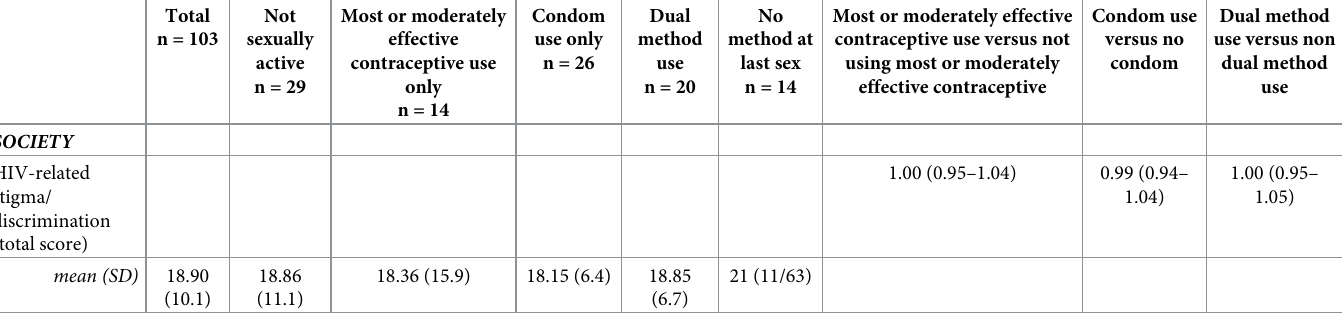
Table 4. Description of society-level factors among young HIV-infected study participants and association between these factors and most or moderately effective contraception use only, condom use only, and dual method use at last coitus. Total n = 103